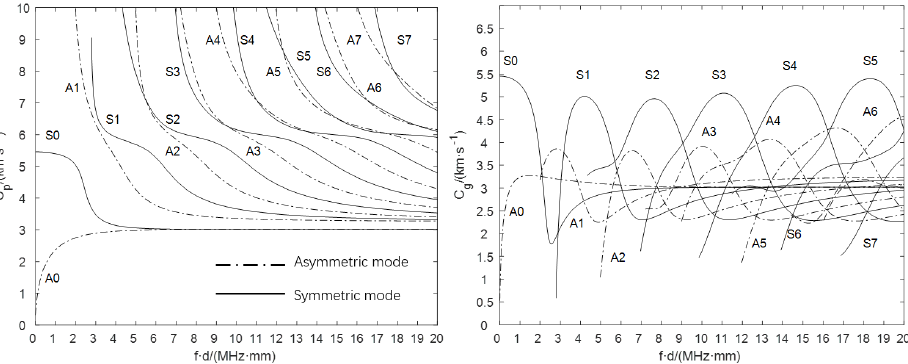
Figure 6. ( left ) Phase velocity ( C p ) and ( right ) group velocity ( C g ) of the 5A06 brand aluminum alloy plate under different frequency ( f ) and plate thickness ( d